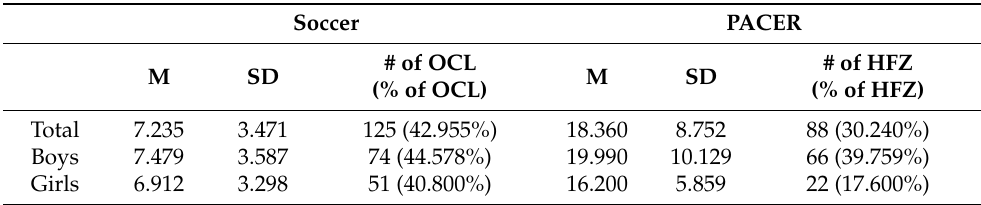
Table 1. Descriptive statistics of manipulative skill assessments and PACER test by gender and total sample. Soccer